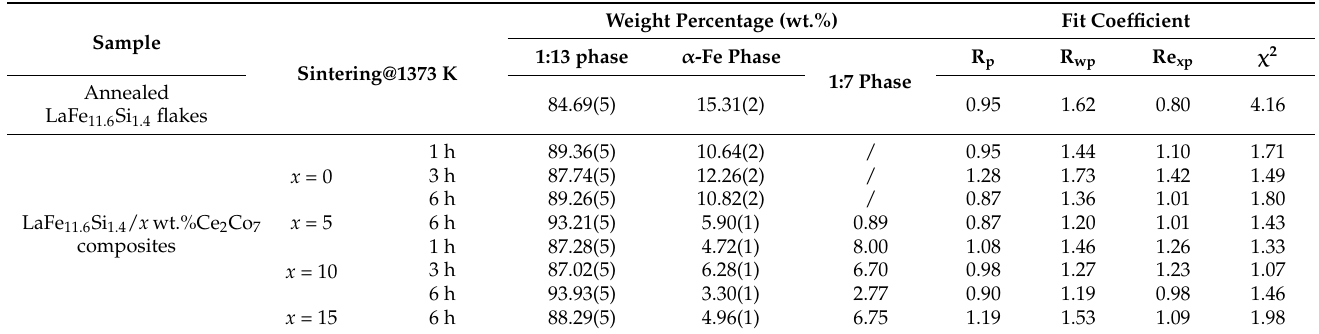
Figure 1. ( a ) XRD patterns for LaFe 11.6 Si 1.4 / x wt.%Ce 2 Co 7 ( x = 0, 5, 10 and 15) composites sintered at 1373 K for 6 h; ( b ) XRD patterns for binder-free LaFe 11.6 Si 1.4 composites sintered at 1373 K for 1, 3 and 6 h, respectively; ( c ) XRD patterns for LaFe 11.6 Si 1.4 /10wt.%Ce 2 Co 7 composites sintered at 1373 K for 1, 3 and 6 h, respectively. Table 1. The weight percentages of phases in the LaFe 11.6 Si 1.4 / x wt.%Ce 2 Co 7 ( x = 0, 5, 10 and 15) sintered composites and fit